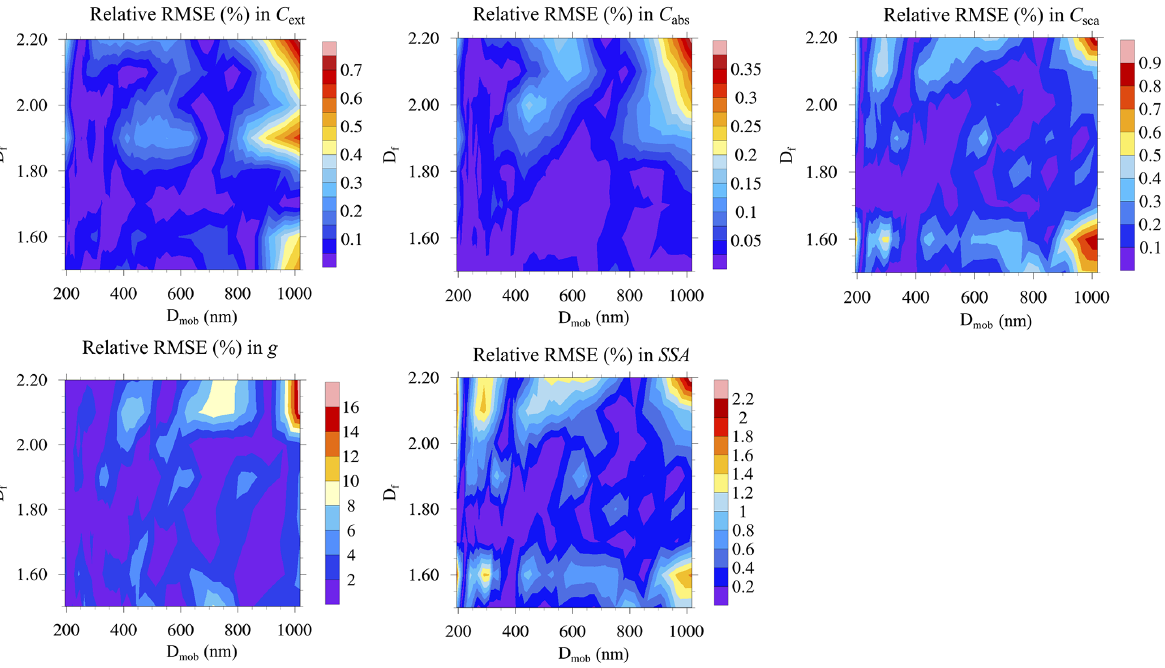
Figure 14. The relative RMSE between MSTM-modelled and parameterized values of C ext , C abs , C sca , g , and SSA for various cases of fractal dimension ( D f ) at λ = 660nm. In this case, the fraction of organics ( f organics ) amounts to 50%.